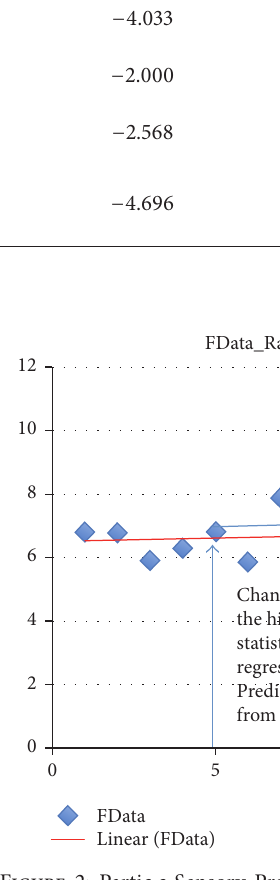
Figure 2: Partic.c Sensory Processing plot of regression on data with change point and